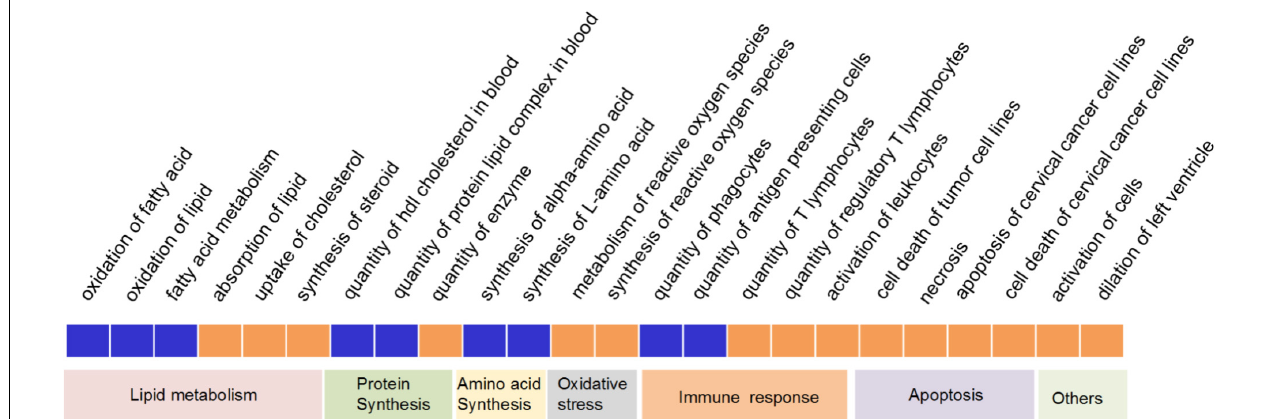
FIGURE 4 | Significantly repressed or activated functions in the liver of gnotobiotic mice on the 2 nd week based on IPA. Blue represent significantly repressed functions ( z -score ≥ 2), while red represent significantly activated ( z -score ≤ –2) functions in PreM group compared to PostM group.